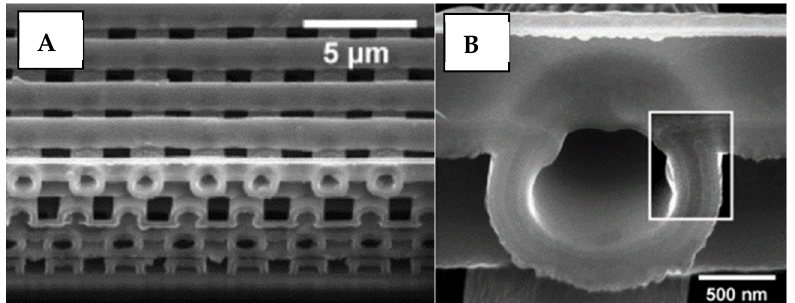
Figure 37. Magnification of hollow “woodpile” microstructure. The lattice design is made of silicon and formed using a direct ink written polymer scaffold that was then silicon-coated and melted to produce the hollow structure. The lattice is 8 by 8 with lateral dimensions of 250 μ m by 250 μ m. ( A ) Magnified image of lattice architecture with a scale bar of 5 μ m. ( B ) Magnified image with a scale bar of 500 nm]. (Reprinted from [161], with the permission of John Wiley & Sons Inc.).